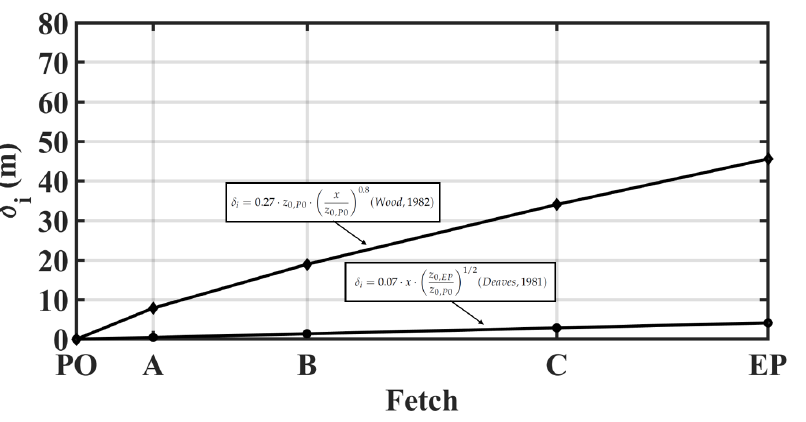
Figure 2. Inner boundary layer height versus the fetch according to empirical equations